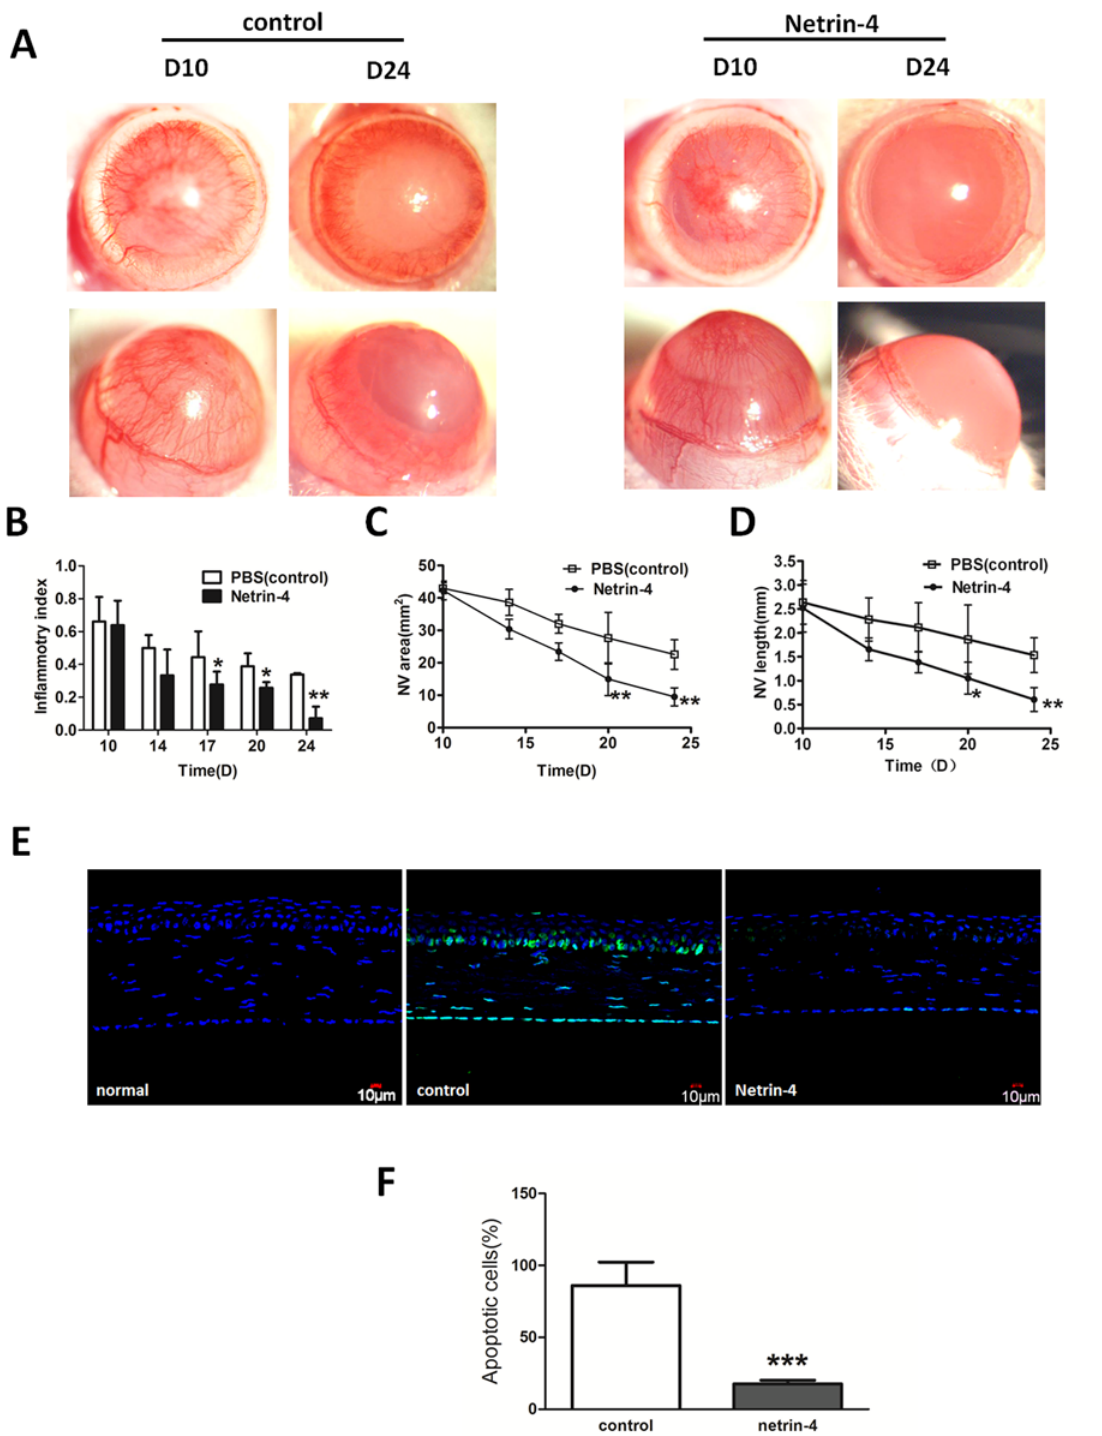
Fig 6. Netrin-4 promotes the regression of corneal neovascularization and inhibit apoptosis after alkali burns. (A) Ten days after the injury, dense neovascularization reached the central cornea. In this experiment, netrin-4 treatment began on day 10. By day 24, the new blood vessels regressed from the central cornea to the peripheral cornea in the control group. In contrast, almost all the new blood vessels had regressed to the limbal area in the netrin-4 treatment group by day 24. (B) The inflammatory index continuously decreased from day 10 to day 24 in both groups, while the index was significantly lower in the netrin-4 treatment group on days 17, 20, and 24 ( * p < 0.05). (C) The NV area gradually reduced from day 10 to day 24 in both groups. There was